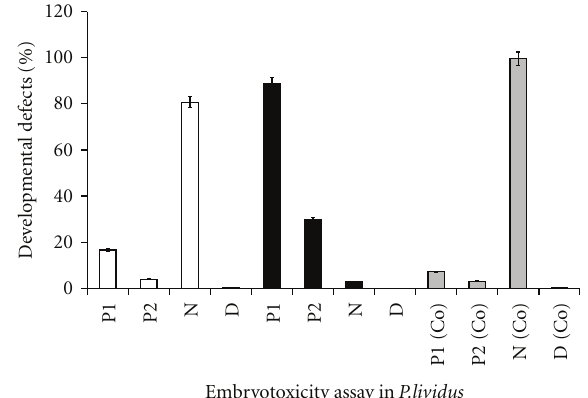
Figure 1: Comparison of developmental defects and mortality in P. lividus embryos following exposure over the range of zygote to pluteus stage. The gray bar represents the untreated negative control (C 0 ). Unpolluted and polluted amniotic liquid-induced develop- mental defects are represented, respectively, by white and black bars. P1, per cent larval malformations; P2, per cent developmental arrest at blastula/gastrula stage; D, per cent embryonic mortality, N, normal larvae. Results are expressed as means ± SE from six separate experiments.